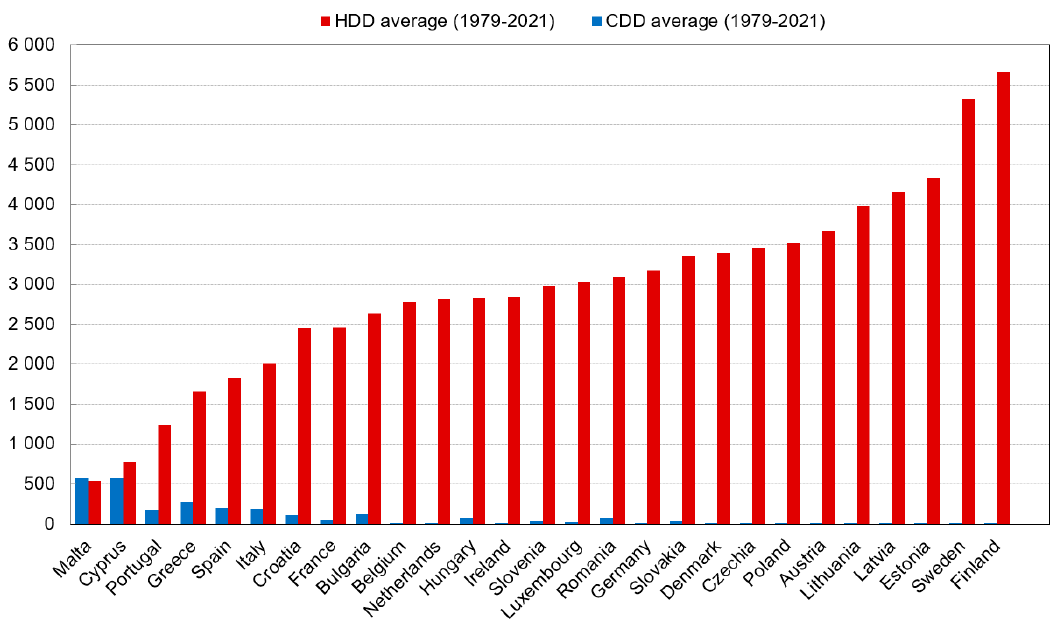
Figure 6. Average HDD and CDD (period 1979–2021) for EU-27 countries. Source: Eurostat [164].